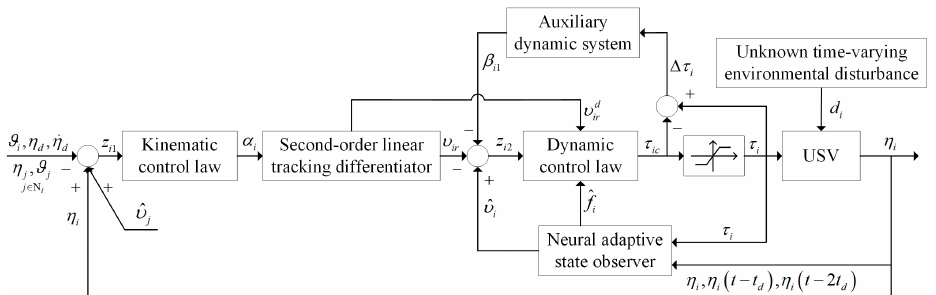
Figure 2. The structure diagram of swarm control for